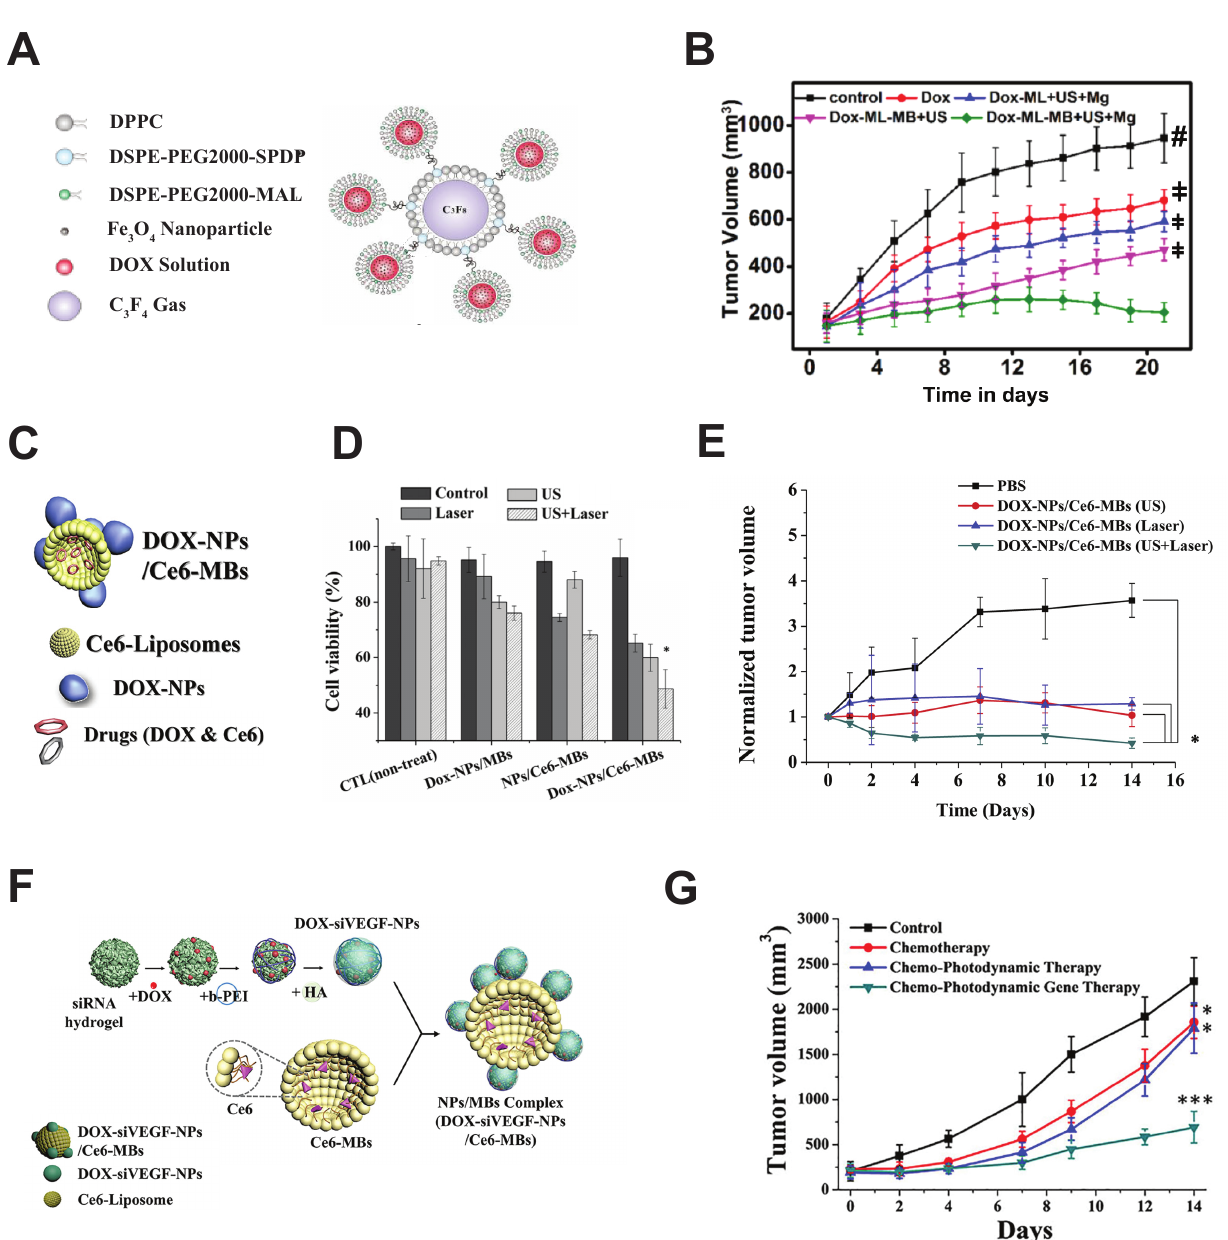
Figure 5. Combined external stimuli enhances cargo delivery from microbubble–nanoparticle com- plexes. ( A ). Magnetically-responsive iron oxide nanoparticle-containing liposomes were loaded with DOX and covalently linked to microbubbles. ( B ) Dual micro-complex stimulation by both magnetic field and ultrasound (DOX-ML-MB + US + Mg, green) had a greater inhibitory effect on tumor growth than either stimulus alone, ‡ p < 0.05, # p < 0.001. ( A , B ) Adapted with permission from [204], copyright 2020 American Chemical Society. ( C ) DOX-loaded albumin nanoparticles were linked to Ce6 photosensitizer-loaded microbubbles. ( D ) Combining ultrasound-mediated delivery of the DOX and Ce6 photosensitizer with PDT significantly improved treatment efficacy in vitro (DOX-NPs/Ce6- MBs + US + Laser) and ( E ) inhibition of tumor growth in vivo, * p < 0.05. ( C – E ) reprinted from [206], copyright 2018, with permission from Elsevier. ( F ) Polymer nanoparticles loaded with DOX and therapeutic siRNA were covalently linked to the Ce6-containing microbubbles. ( G ) The combination of chemotherapy, gene therapy, and photodynamic therapy with ultrasound targeting (green line) significantly inhibited tumor growth, * p < 0.05, *** p < 0.001. ( F , G ) reprinted from [207], copyright 2020, with permission from